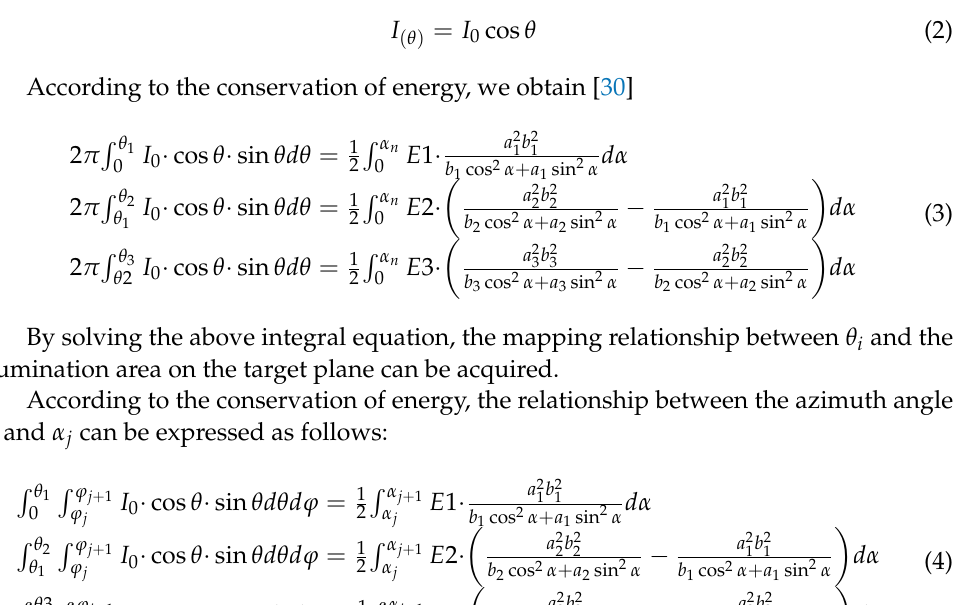
Figure 5. Division of the target plane for low beam. I 0 is the central intensity of the LED source; I ( , the intensity distribution of light θ ) in the θ direction; θ , the angle between the emergent light and the optical axis; and the relationship between I ( and I 0 can be expressed as θ )